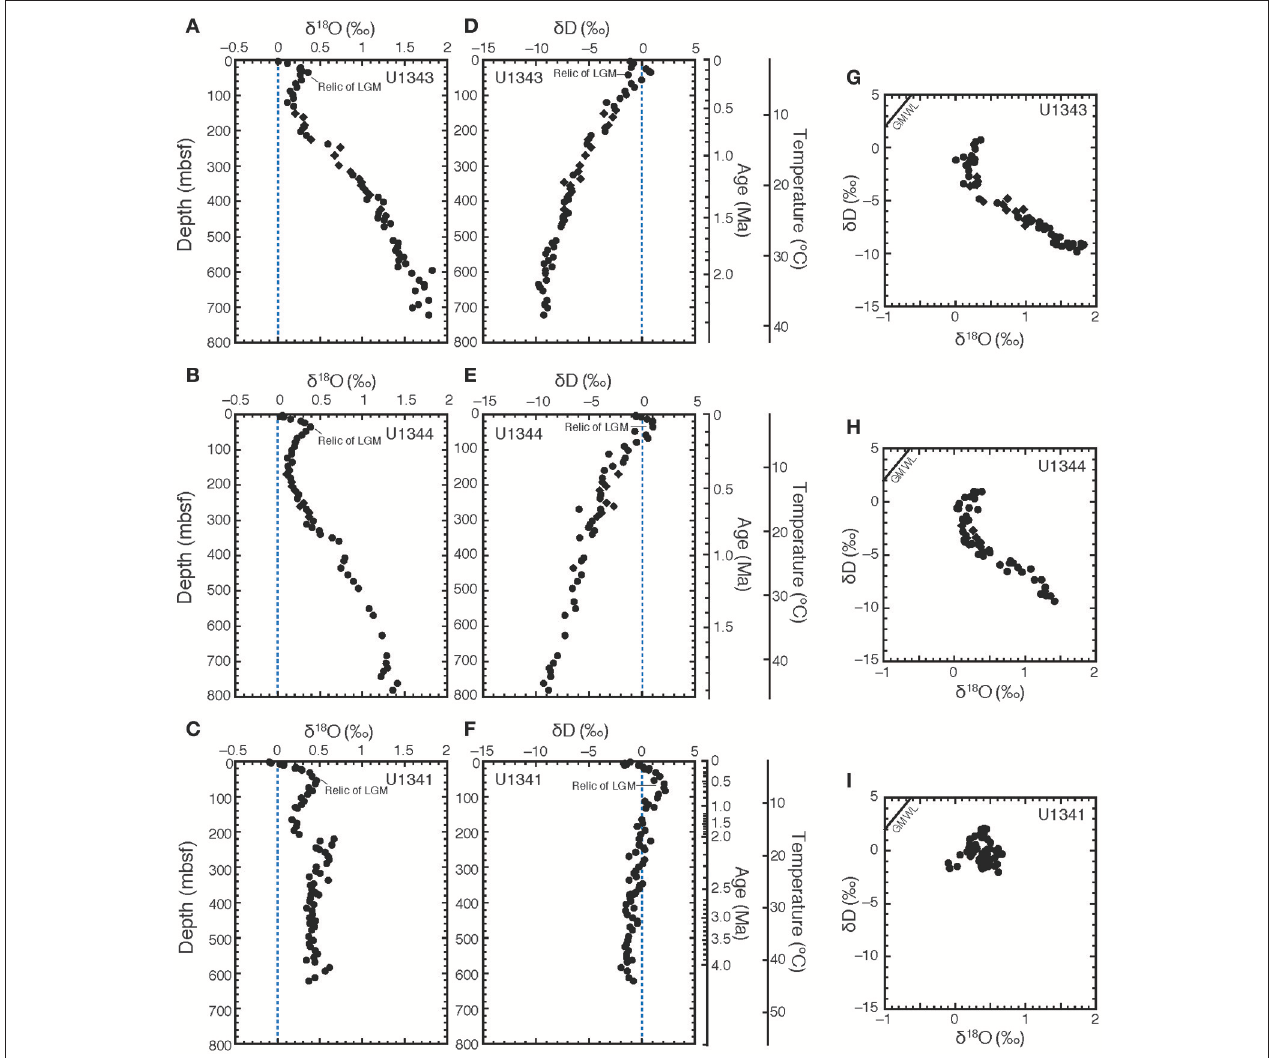
FIGURE 3 | Stable oxygen and hydrogen isotopic compositions of porewater at Sites U1341, U1343, and U1344. Vertical profiles of porewater are shown of δ 18 O for (A) U1343, (B) U1344, and (C) U1341, and of δ D for (D) U1343, (E) U1344, and (F) U1341. δ 18 O vs. δ D for (G) Sites U1343, (H) U1344, and (I) U1343 are also shown. Diamonds show samples with discrete low Cl − spikes between 200 and 420 mbsf at Sites U1343 and U1344. The blue dashed lines in (A–F) show the value of standard mean ocean water (0 ‰ VSMOW). Black solid lines in (G–I) show global meteoric water line